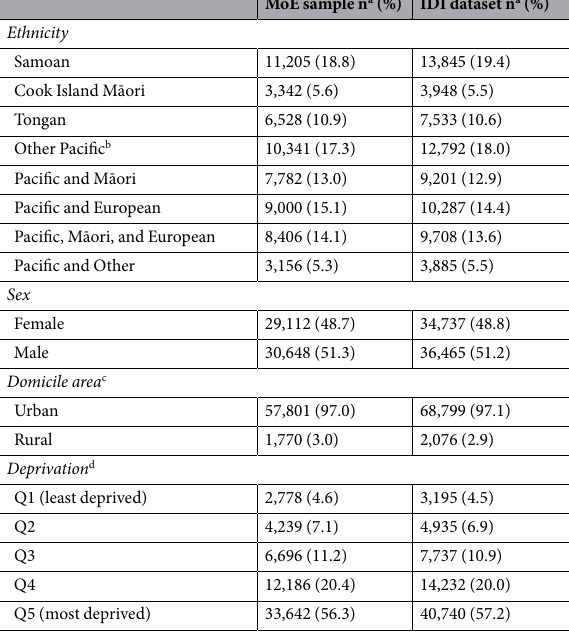
Table 1. Distribution of selected demographic variables for the full IDI dataset, and those eligible for this study (MoE linked sample). Note: a Randomly rounded to base 3, as per the confidentiality rules of SNZ. b Includes children with level II information who were not Samoan, Cook Island Māori, or Tongan; children with two or more Pacific ethnic identifications; and, Pacific children with only level I information available. c Data missing for 327 (0.5%) in the IDI dataset. d Data missing for 363 (0.5%) in the IDI